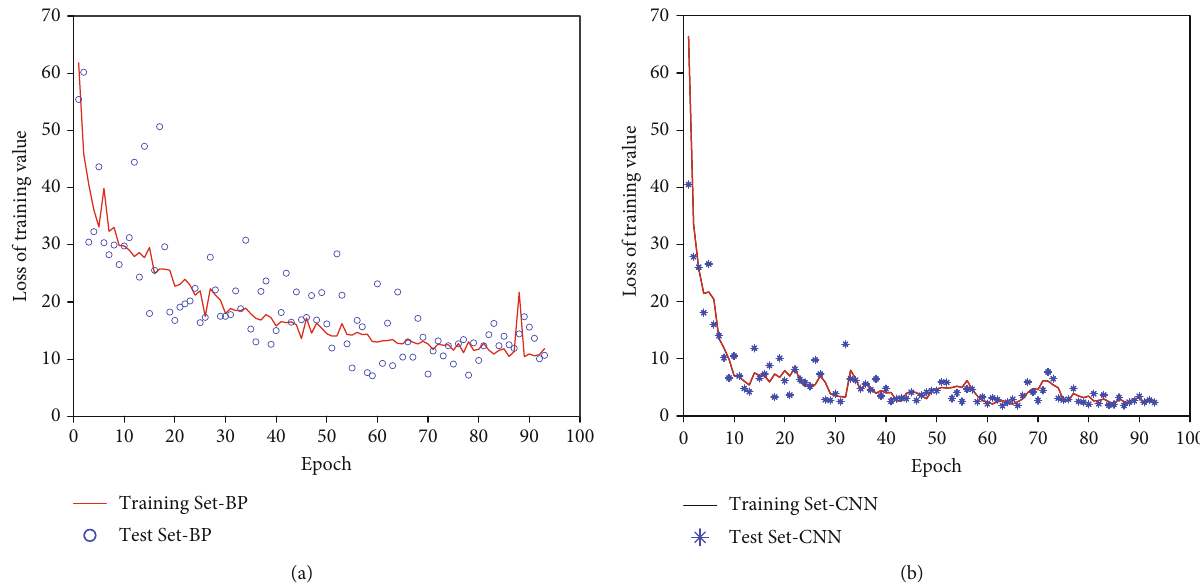
Figure 7: Curves of loss function during neural network training: (a) loss curves calculated by BP neural network; (b) loss curve calculated by